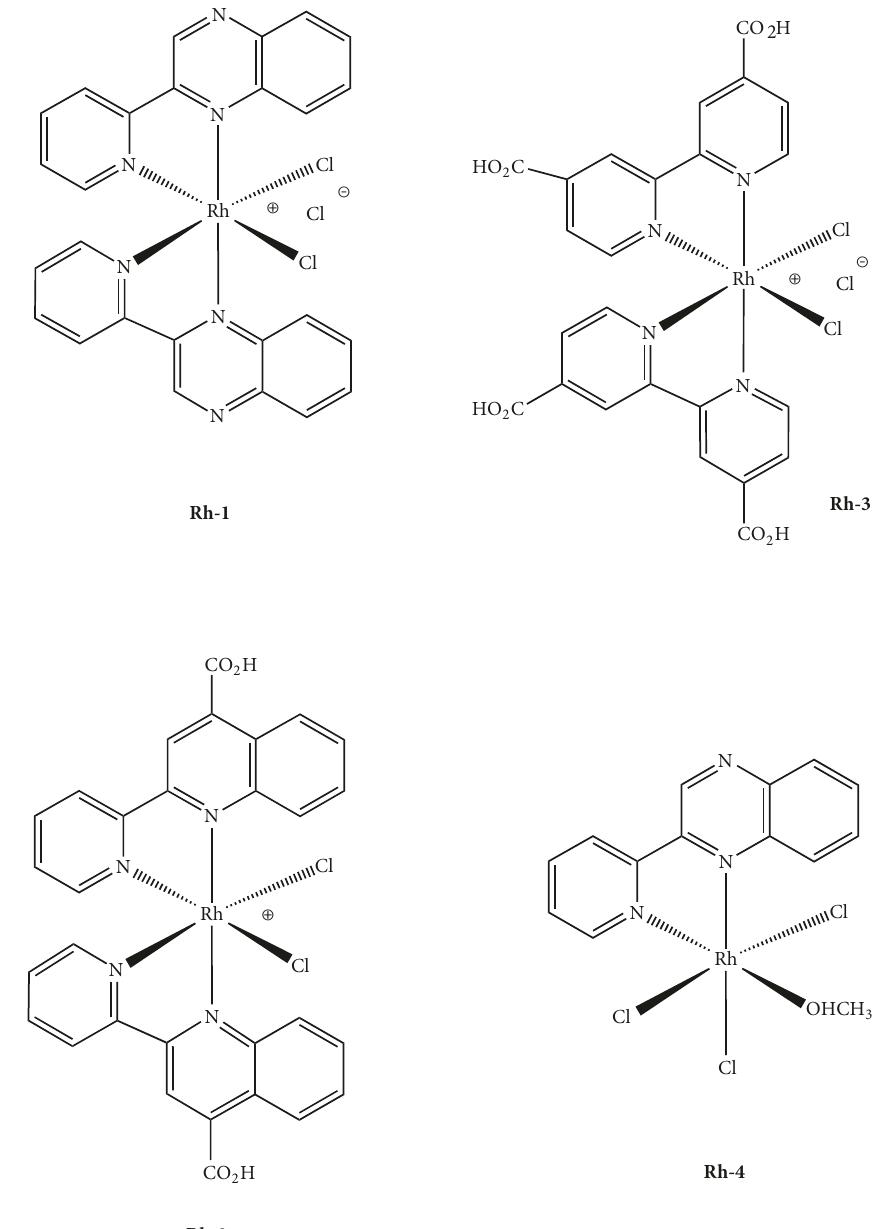
Figure 4: Molecular structures of rhodium(III) inhibitors of